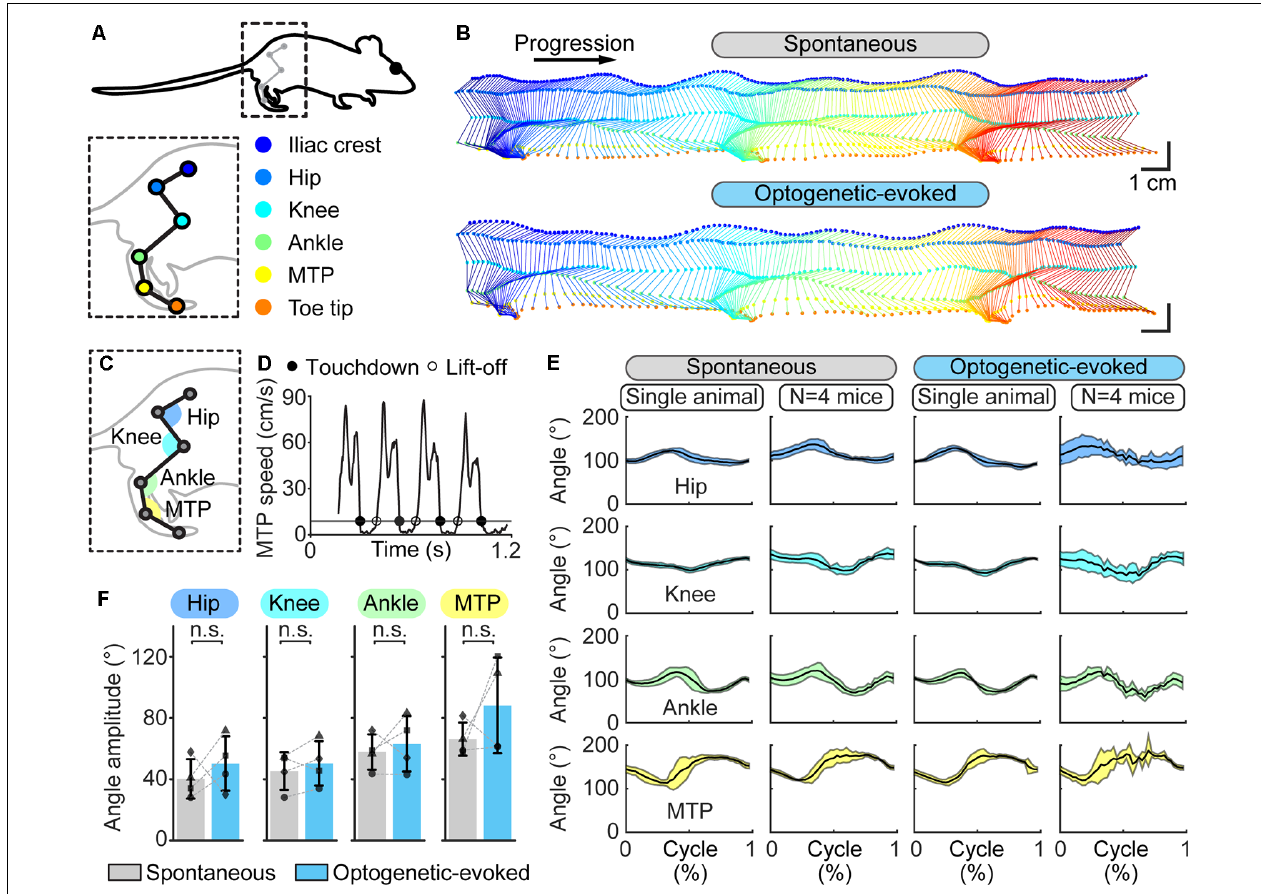
FIGURE 4 | Hindlimb kinematics during spontaneous locomotion and locomotion evoked by optogenetic stimulation of the cuneiform nucleus (CnF) in Vglut2-ChR2-EYFP mice in a linear corridor. (A) Six hindlimb joints were labeled with a white paint marker and were filmed from the side at 300 fps in a transparent linear corridor and the trajectory of each joint was extracted with DeepLabCut and plotted in a different color (see “Materials and Methods” section). (B) Side view of the hindlimb joints during spontaneous locomotion (top) and optogenetic-evoked locomotion (470 nm laser, 10 s train, 20 Hz, 10 ms pulses, 8% of laser power) (bottom). Total time elapsed from first to last frames is 700 ms (top) and 500 ms (bottom). (C) Joint angles at the hip, knee, ankle, and metatarsophalangeal joint (MTP) levels were calculated frame by frame using the position of the joint of interest and those of two proximal joints. (D) Cycle duration was defined as the time duration between two consecutive touchdowns of the MTP using a speed threshold of 9 cm/s to define the transitions between swing and stance phases. Full circles are touchdowns; empty circles are lift-offs. (E) Joint angles (mean ± SD) at the hip, knee, ankle and MTP levels plotted for a normalized locomotor cycle during spontaneous locomotion (29 steps) and locomotion evoked by optogenetic stimulation (31 steps; 470 nm laser, 10 s train, 20 Hz, 10 ms pulses, 8% of laser power). For the pooled data, joint angles (mean ± SD) of four animals plotted for a normalized locomotor cycle during spontaneous locomotion (8–29 steps per animal) and locomotion evoked by optogenetic stimulation are shown (2–31 steps per animal; 470 nm laser, 10 s train, 20 Hz, 10 ms pulses, 8–15% of laser power). (F) Amplitude of the hip, knee, ankle, and MTP angles measured in four animals during spontaneous and optogenetic evoked locomotion (same data as in E ). n.s., not significant, P > 0.05, paired t